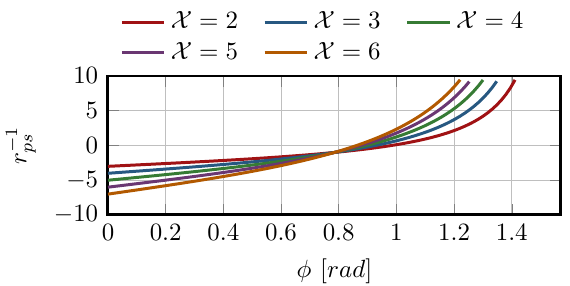
Figure 4. Transmission ratio of PS-CVT for typical values of X .